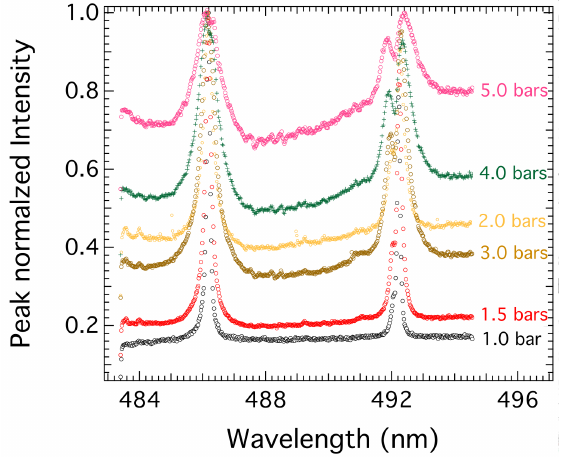
Figure 11. The superposition of the available experimental spectra of the H- β 486.1 nm (left peak) and the He I 492 nm (right peak) lines measured at room temperature for pressures in the range of 1–5